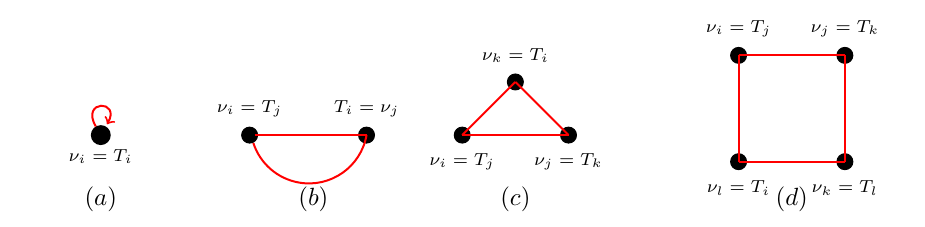
Figure 7.2: (a) Self Loop: when ν i = T i , (b) Parallel Edges: ν i = T j , ν j = T i , (c)